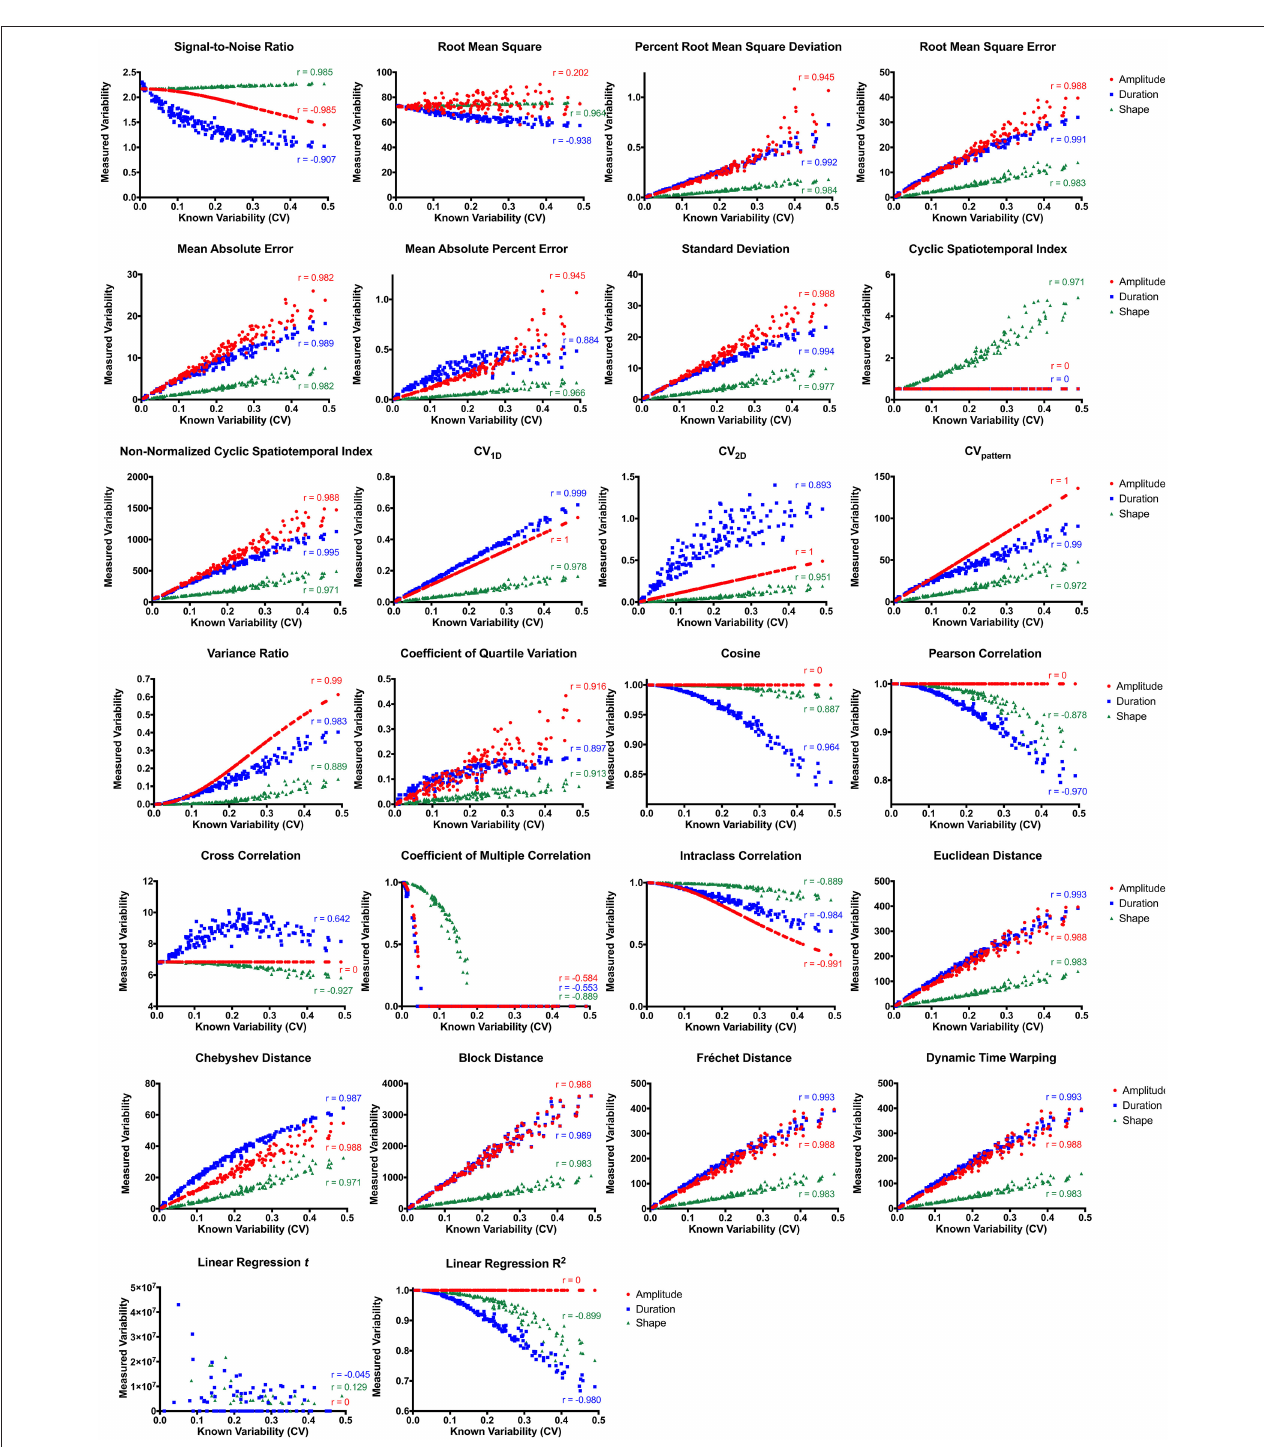
FIGURE 4 | Variability metric correlations between known and measured variability with permutations in amplitude (red), duration (blue), and waveform shape (green). CV, coefficient of